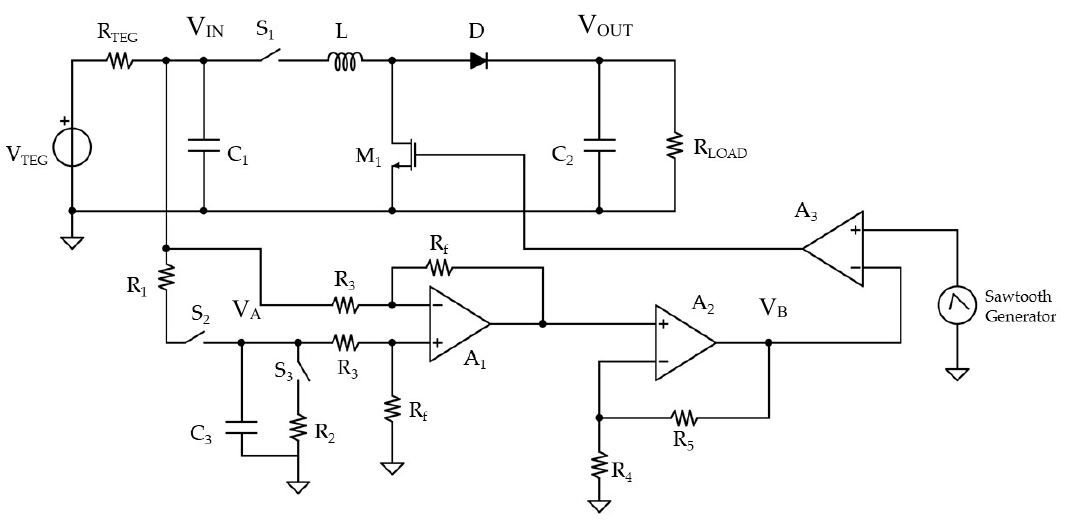
Figure 11. Complete scheme of the implemented DC / DC boost converter with FCOV MPPT algorithm.